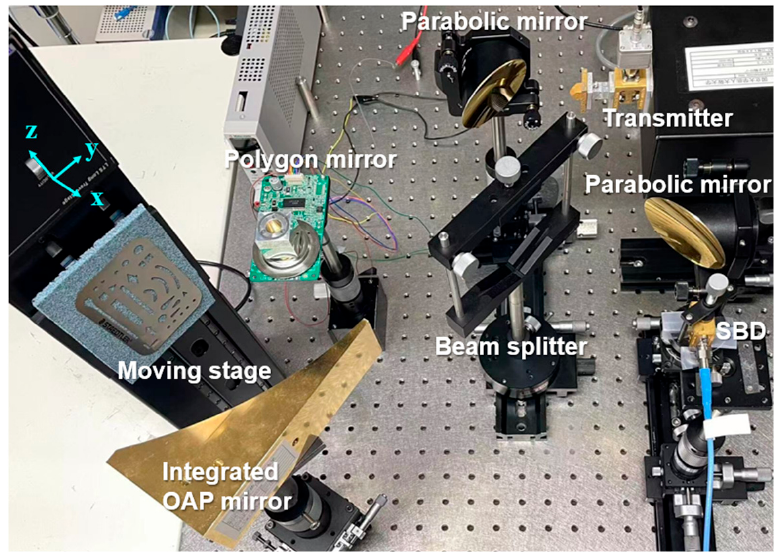
Figure 9. Experimental setup of the imaging scanner system. (SBD: Schottky barrier diode.)